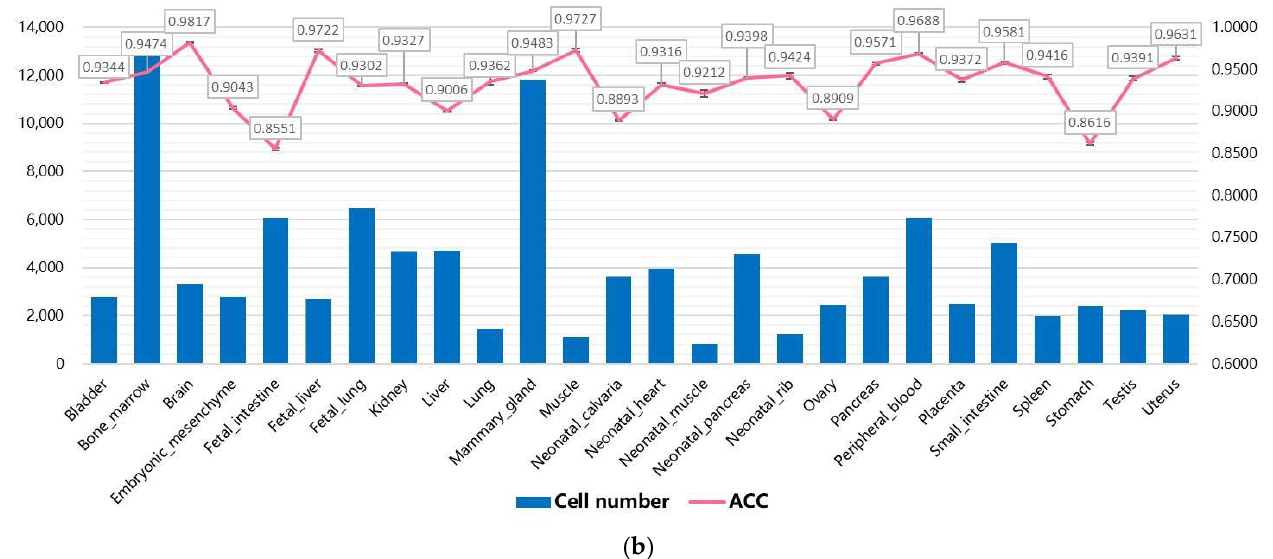
Figure 2. Performance of scTransSort on internal test datasets. ( a ) Accuracy of scTransSort in annotating cells from 35 human tissues. ( b ) Accuracy of scTransSort in annotating cells from 26 mouse tissues. The bar graph shows the number of cells per tissue.